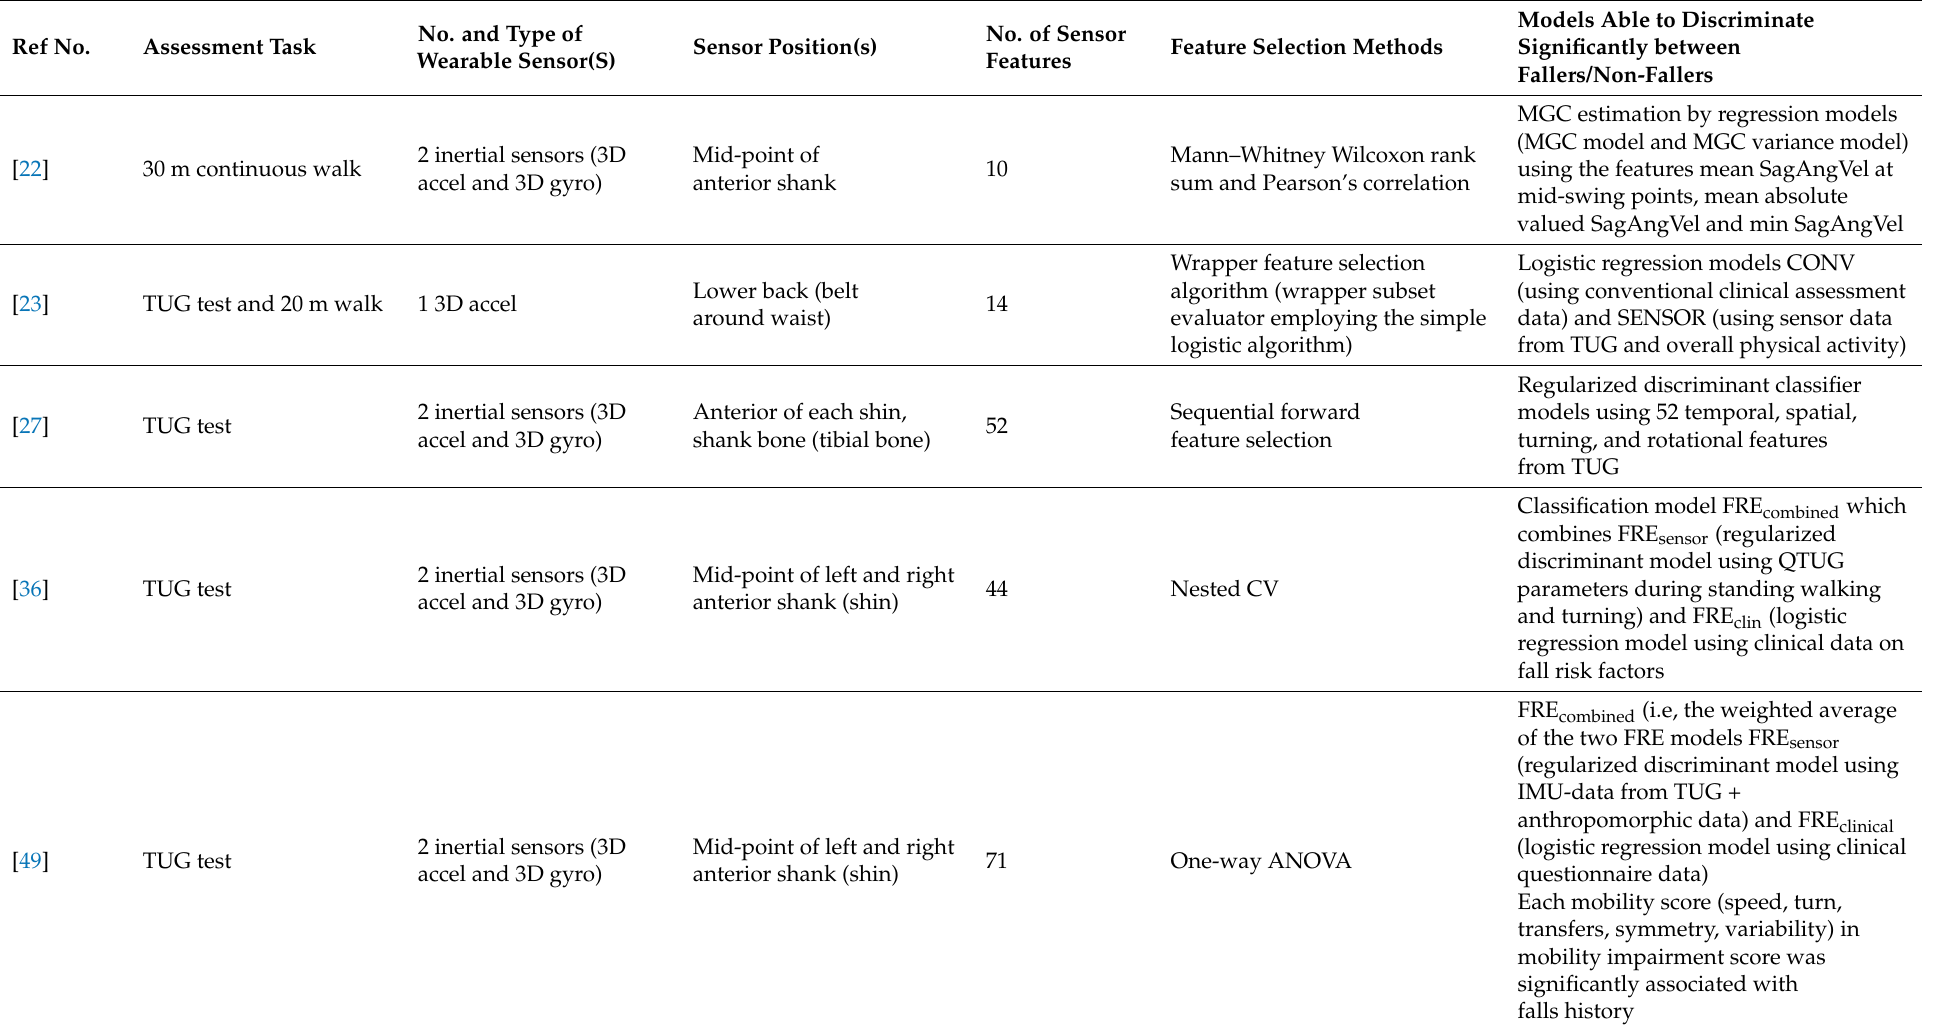
Table 5. Characteristics of fall risk assessment systems using classification models without machine learning algorithms. CV = cross-validation, MGC = Minimum ground clearance, SagAngVel = Angular velocity in the sagittal plane.